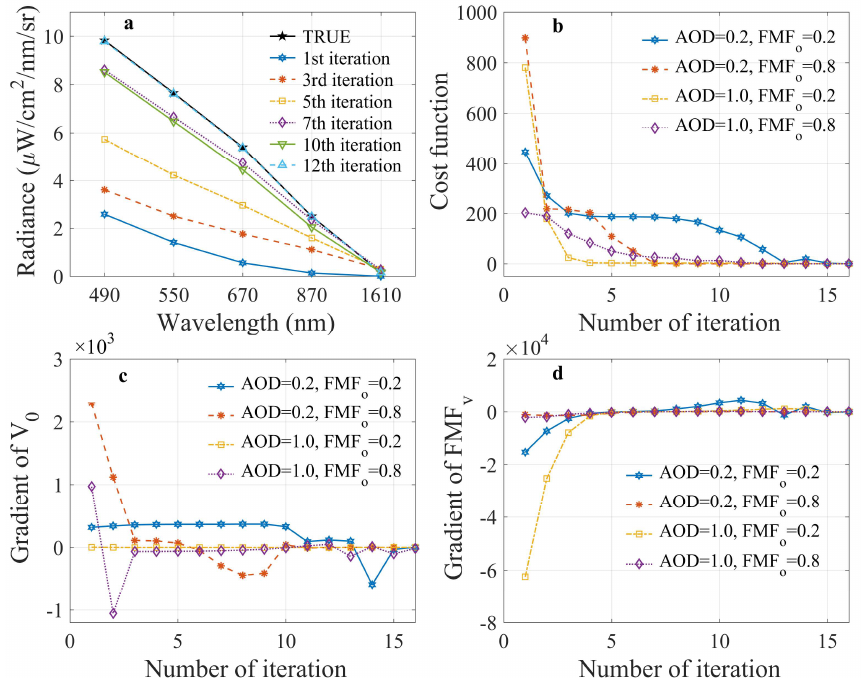
Figure 5. Illustration of the iterative process. ( a ) plots the simulated radiances of the five wavelengths at each iteration and the true radiances under the condition of AOD = 1.0 and FMF o = 0.8 at 550 nm. ( b ) plots the cost function as a function of the number of iterations under four di ff erent conditions. ( c ) and ( d ) are the gradient vectors of V 0 and FMF v ,